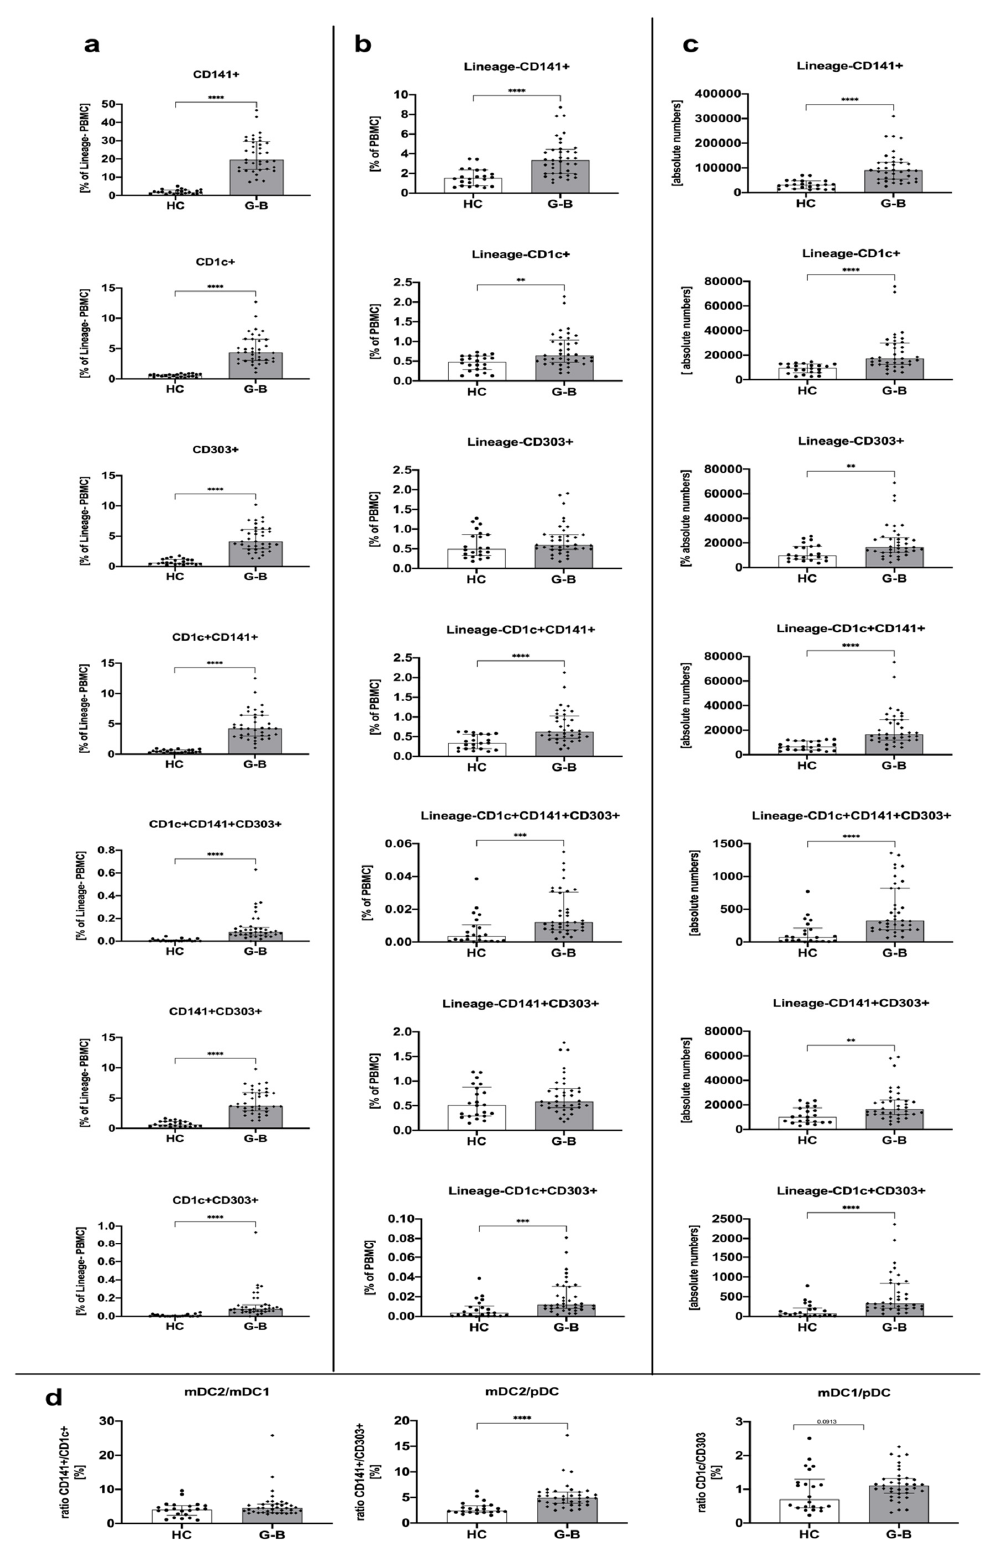
Figure 1. Dendritic cell-related differences among Graves’ disease patients (GD) and the healthy control group (HC). Acquired data were analyzed in the context of dendritic cell (DC) subset frequency within Lineage-negative peripheral blood mononuclear cells (PBMCs) ( a ), the total pool of PBMCs ( b ), as an absolute number of cells ( c ), and the ratio between studied DCs ( d ). Data are presented on each graph as the median with interquartile range. The levels of significant differences were indicated with: ** p < 0.01; *** p < 0.001; **** p <